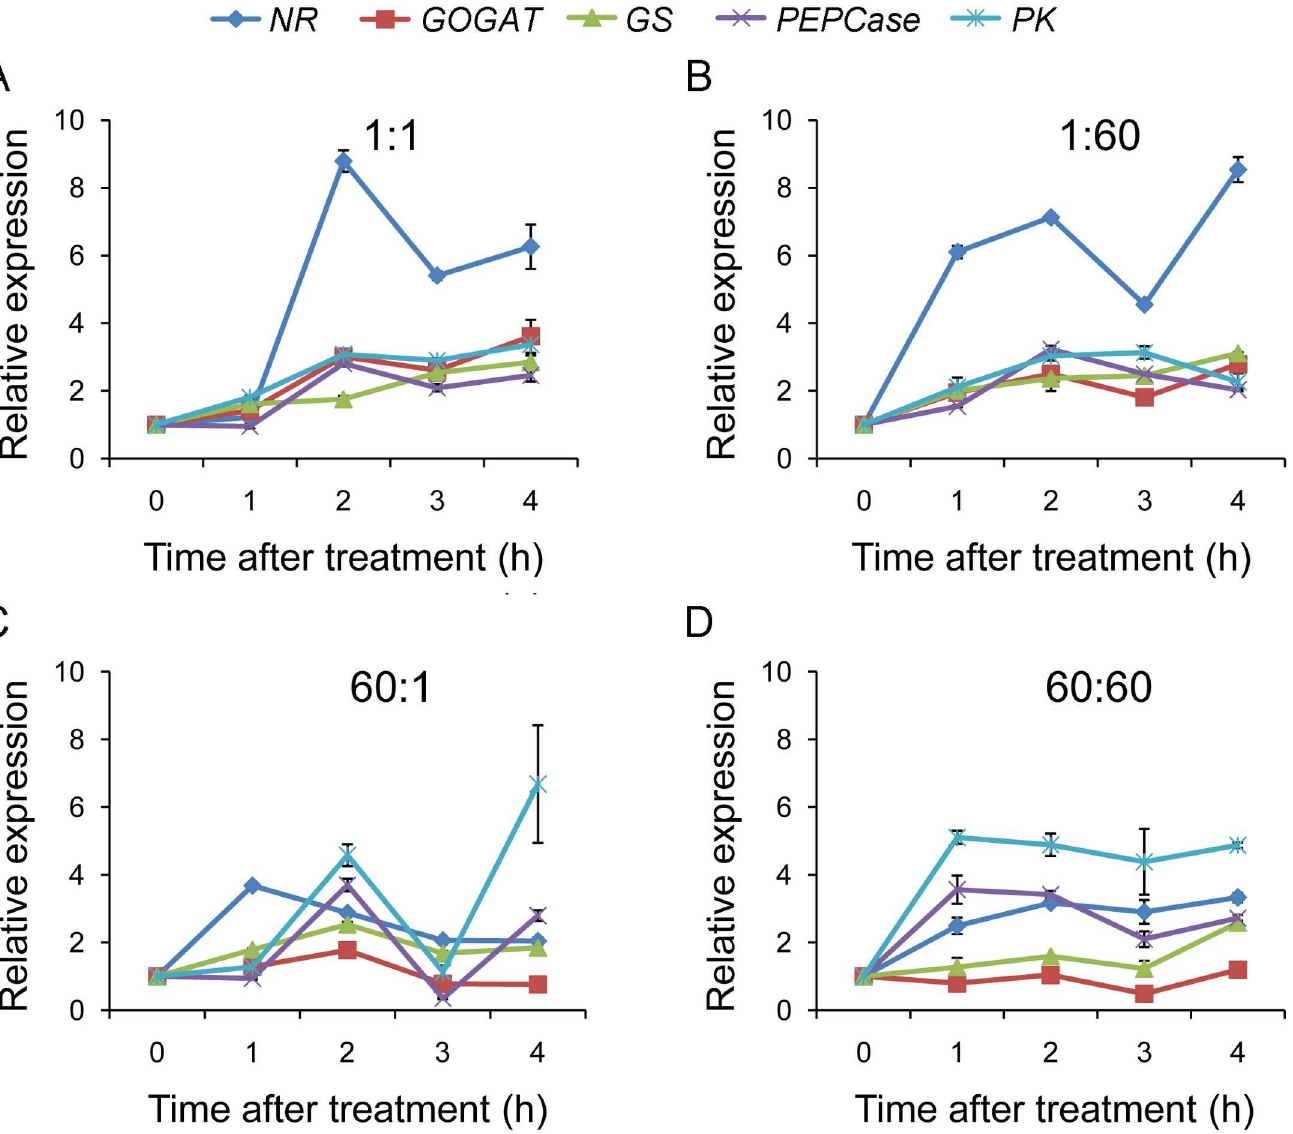
Fig 2. qRT-PCR analysis of CN metabolic genes at different time points after C:N treatments. Expressionpatterns of NR , GOGAT , GS , PEPCase and PK were analyzedin rice seedlings treated with four different C:N conditions (A 1:1; B 1:60; C 60:1; D 60:60) for 1, 2, 3 and 4 h. The beginning of the treatment (0 h) was used as the control and Actin6 served as the internal reference. Values are shown as means ± SDs from three technical replicates. A representative experiment of two biologicalreplicates is shown.